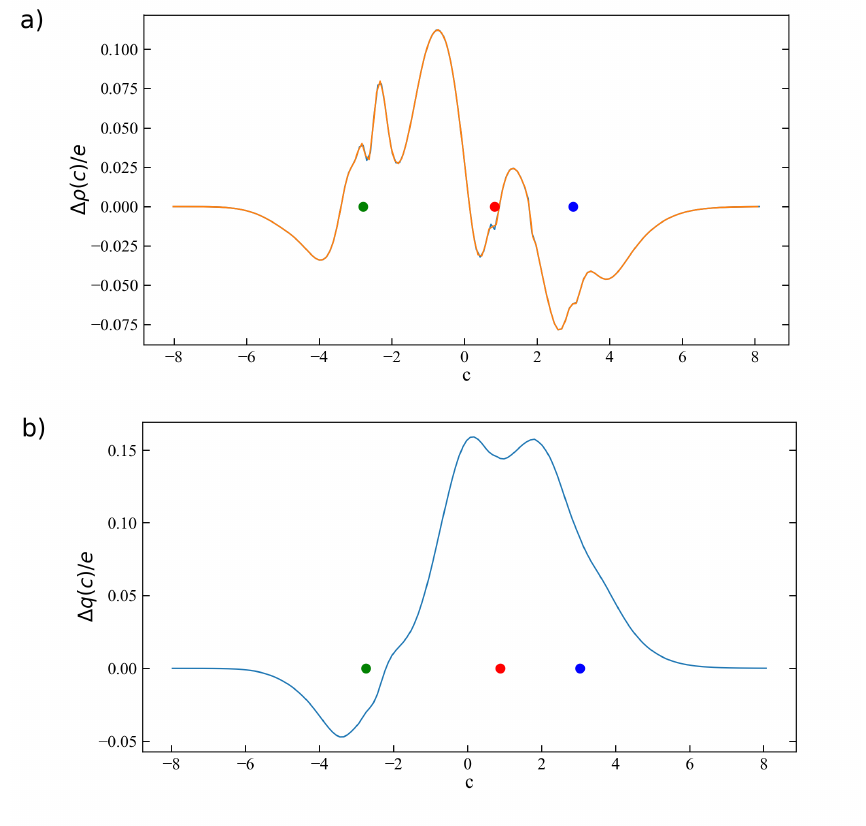
Figure 1. ( a ) ∆ ρ ( c ) from curvilinear CD analysis (blue curve) along a linear c path superimposed to the z axis. ∆ ρ ( z ) from ordinary CD analysis (orange curve) is also shown. ( b ) ∆ q ( c ) from curvilinear CD analysis (blue curve). The positions of the copper, carbon, and oxygen nuclei along the axis are indicated in green, red, and blue,